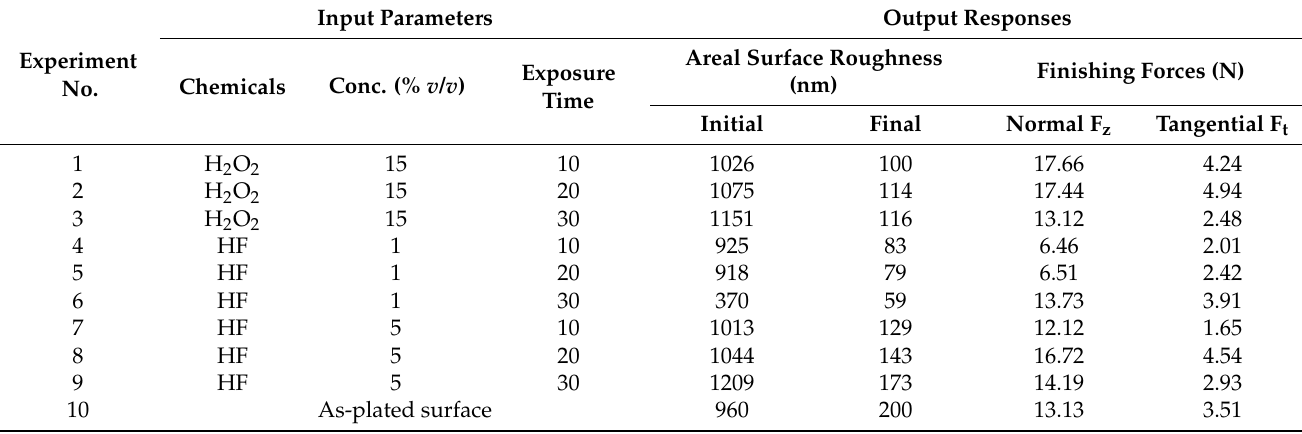
Table 4. Experimental plan and response